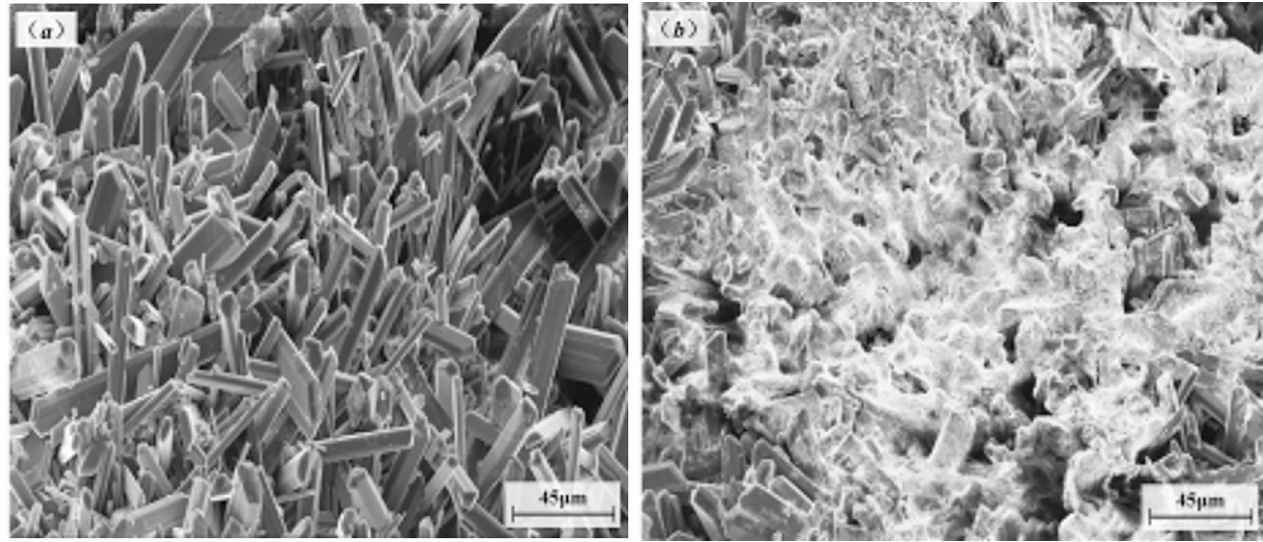
Fig 14. Ore crystal surfaces before and after the addition of